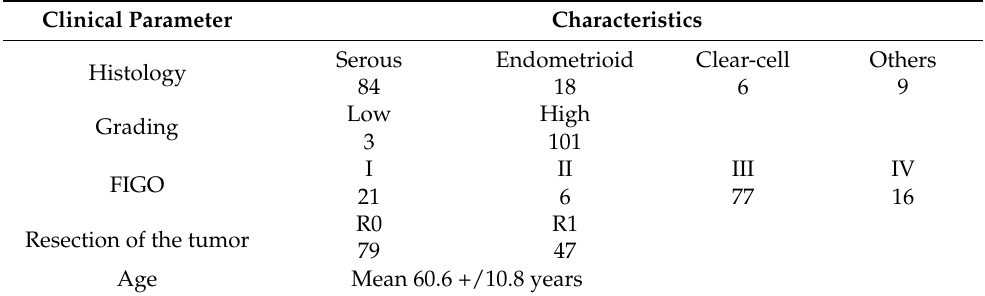
Table 1. Clinical parameters of the patient cohort. Shown in the diagram: Histology of tumor, tumor grading, FIGO stage, resection of tumor mass under surgery and